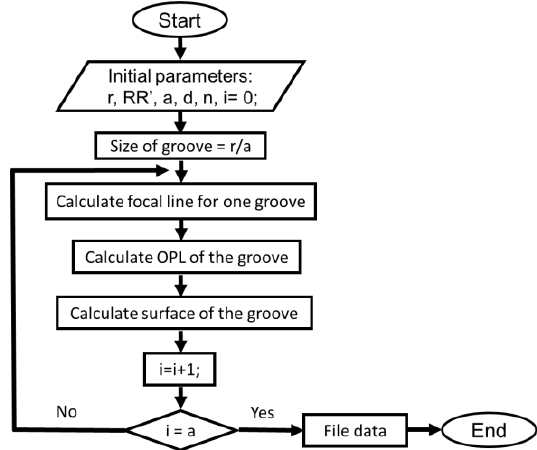
Figure 5. The flowchart of the design process of the linear Fresnel lens.